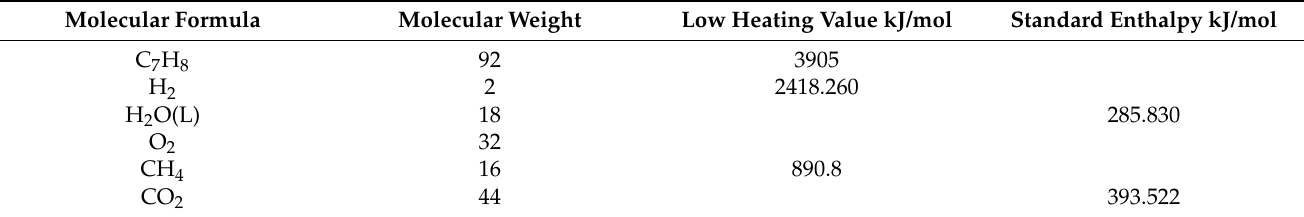
Table 3. The parameters of C 7 H 8 , and required inorganic substances. Molecular Formula Molecular